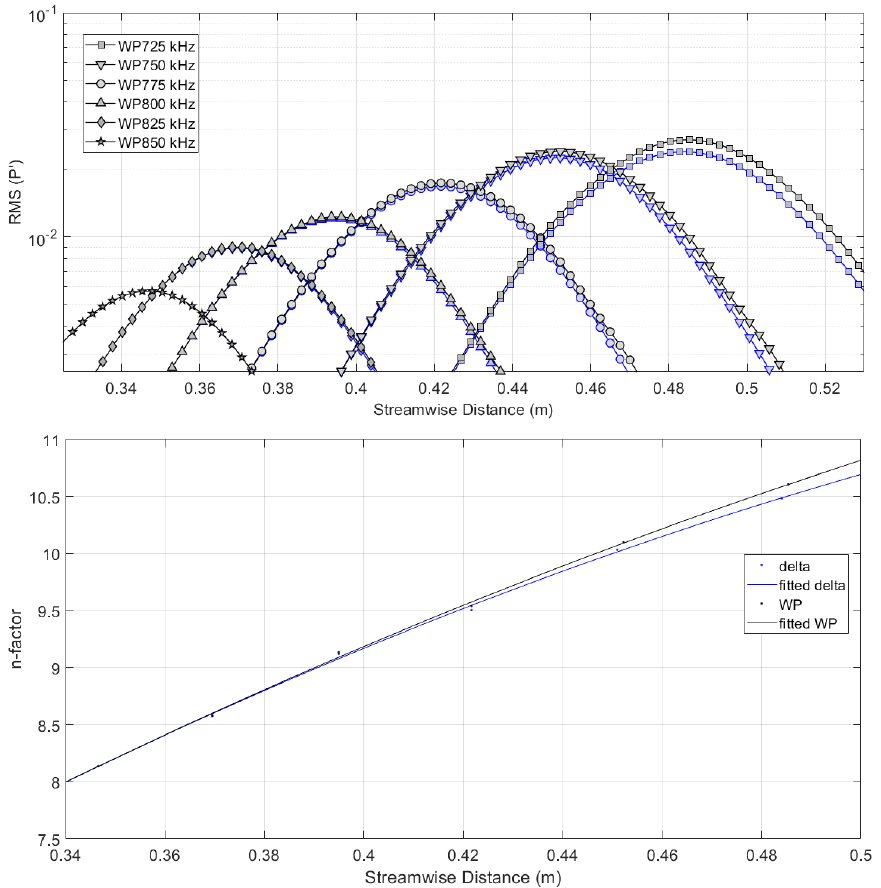
Figure 7. At HIFiRE flight conditions- Upper : NPSE results for a straight cone. Lower : N-factor comparison between traditional discrete (delta-function) and wave packet (WP)